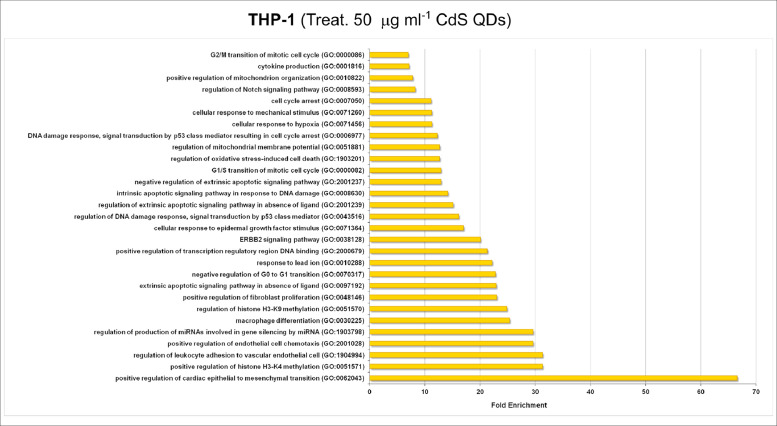
GO enrichment analysis of target genes of THP-1 miRNAs modulated by a higher dose of CdS QDs. Cells were treated with 39 µg ml−1 Cd as 50 µg ml−1CdS QDs. The targets of most of the responsive miRNAs belonged to the GO categories denoted as 'regulation of production of miRNAs involved in gene silencing by miRNA', 'extrinsic apoptotic signaling pathway in absence of ligand', 'regulation of mitochondrial membrane potential', 'cellular response to mechanical stimulus' and 'cytokine production'. Note: GO enrichment analysis were performed using PANTHER software (p < 0.001).